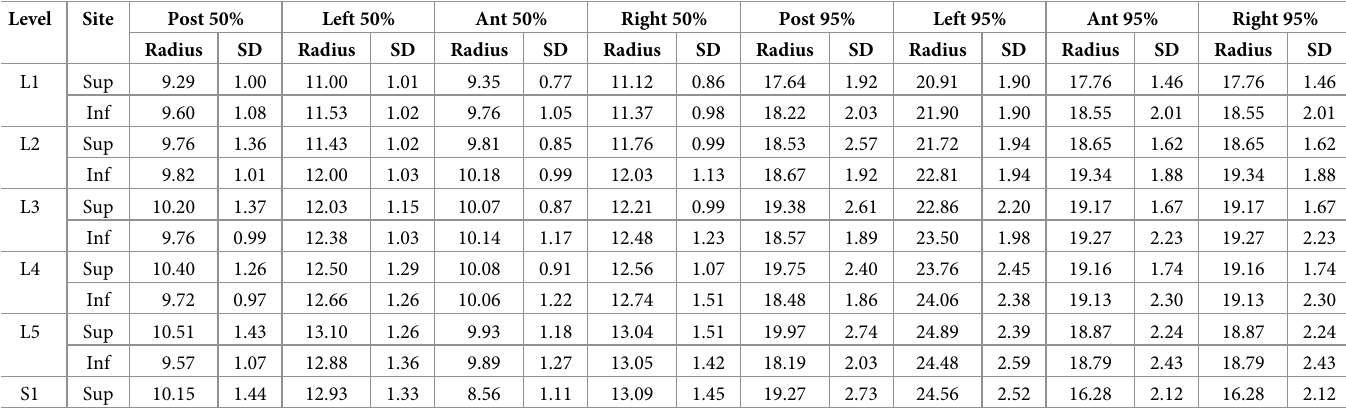
Table 1. Actual distance for 50% and 95% radii by anatomical